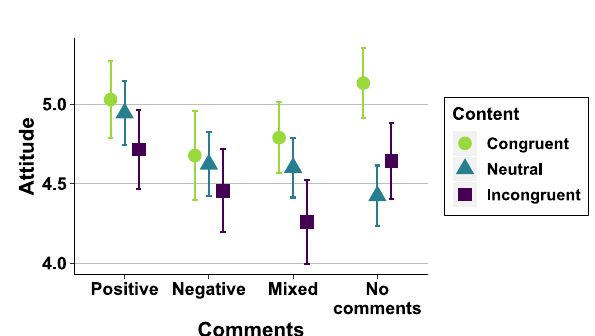
Fig. 3 Interaction effect of comment sentiment and article-content type on attitude . Participants viewed three news articles on a manipulated but ostensibly real social networking site. The ideas conveyed by the article contents were assumed to be congruent, neutral, and incongruent with the participants ’ ideological dispositions. Error bars represent 95%